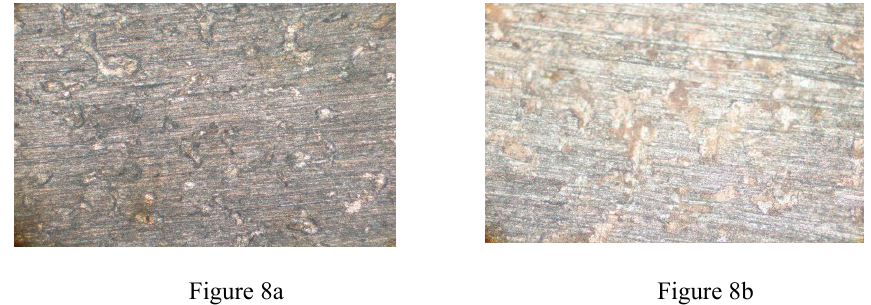
Figure 8. Photomicrograph of MS in presence of HCl (8a) & in presence of SFCN extract (8b).